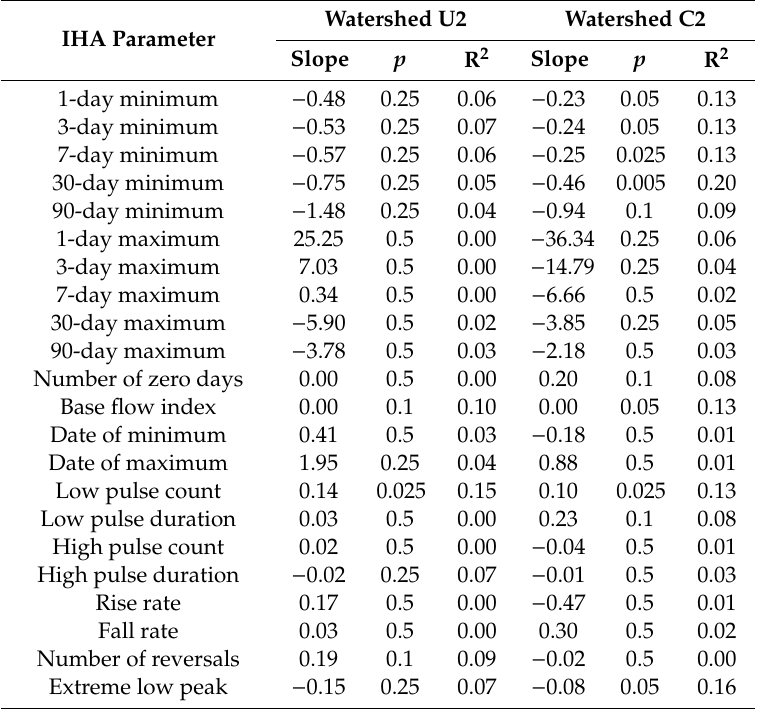
Table A5. Slope, p -value, and R 2 value for IHA single period trend analysis for watersheds U2 and C2. Positive slope values indicate an increase in the